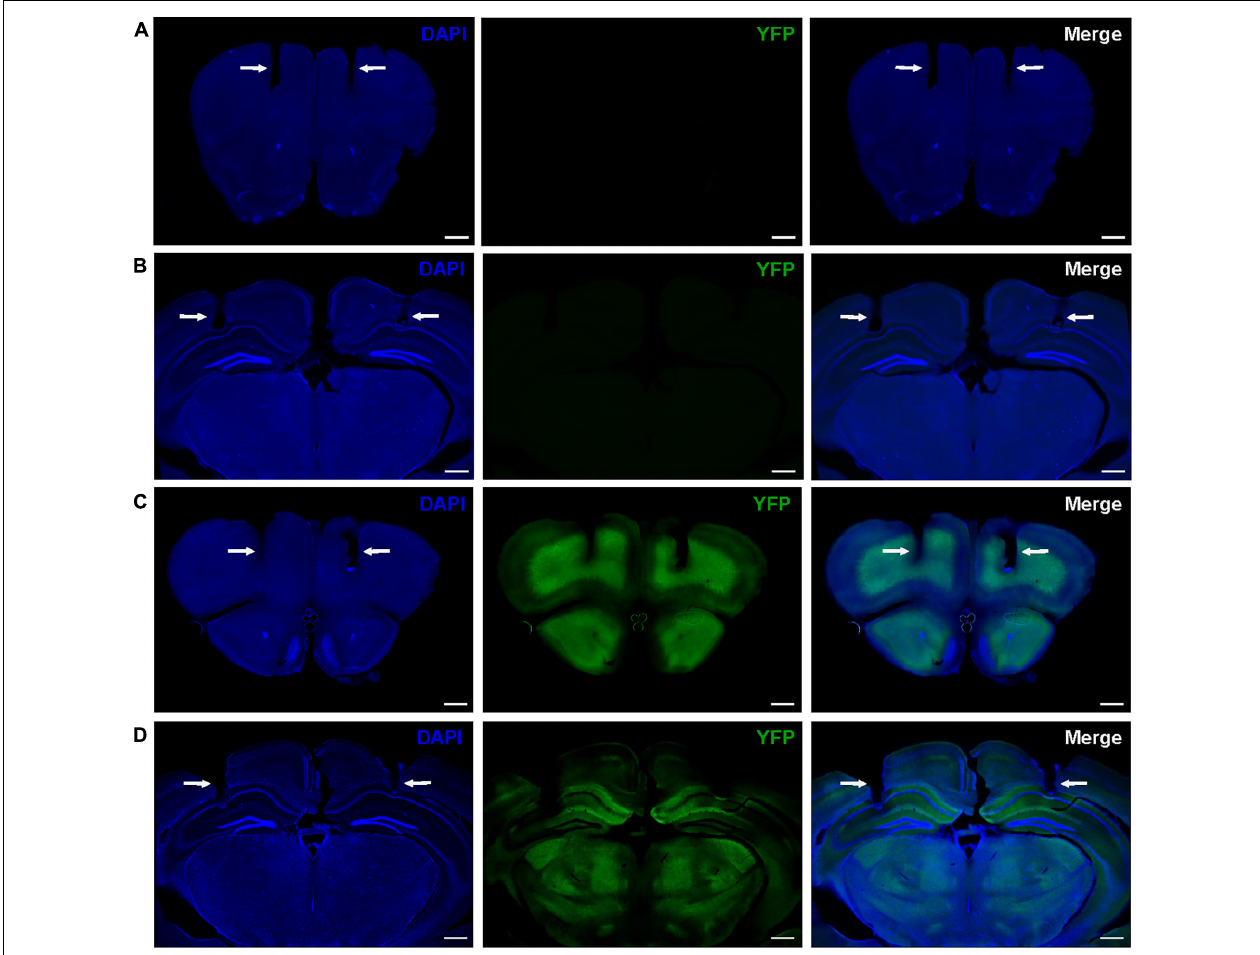
FIGURE 1 | Representative histology showing locations of bilateral electrode tracks in the PFC (A) and HPC (B) of WT mice and the PFC (C) , and HPC (D) of 14-3-3 FKO mice, as indicated by white arrows. High expression of YFP-fused difopein transgene can be seen in 14-3-3 FKO mice (C,D) . Scale bar = 500 µ m.